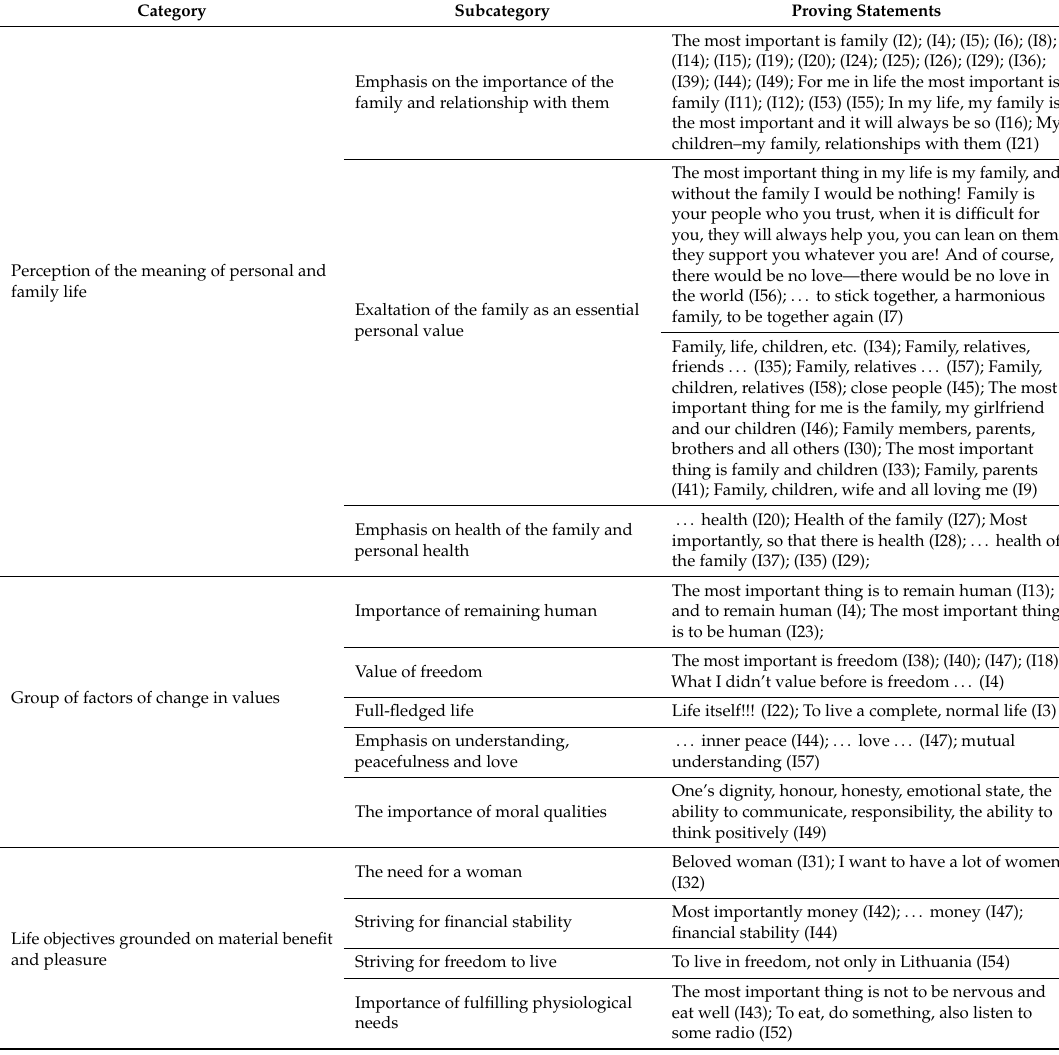
Table 3. Identification of change in goals and meaning of